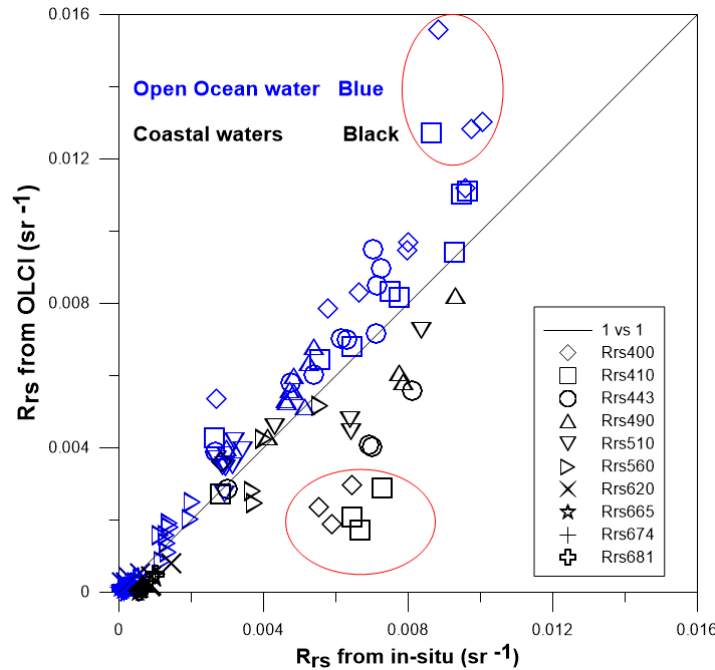
Figure 6. Scatterplot of OLCI-derived versus in situ remote-sensing reflectance in the China Sea, total R 2 = 0.83. The blue scatterplots correspond to the open ocean, the black scatterplots to the coastal waters. The red circles correspond to the outliers for the PRE region (the APD of the outlier points is larger than the mean APD +/ − 3*sigma of the other points.).